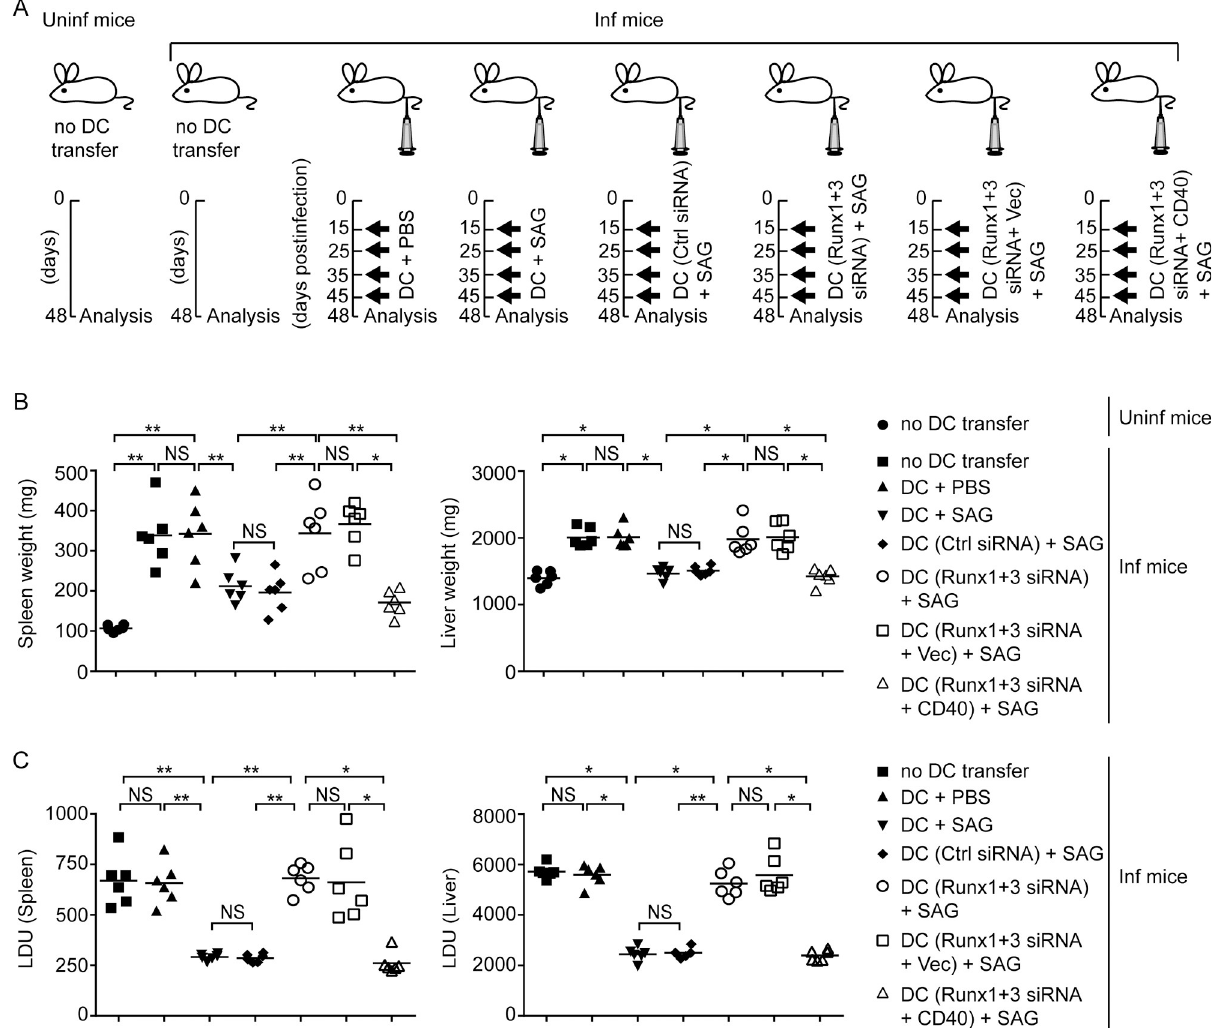
Fig 9. Runx-mediated CD40 expression is required for clearance of LD infection in mice by SAG-treated DCs. (A) Experimental scheme for adoptive transfer experiments. BALB/c BMDCs were treated with PBS or SAG for 24 h. Alternatively, BALB/c BMDCs were transfected with control siRNA, or with Runx1 and Runx3 siRNAs alone or together with an empty vector (Vec) or CD40-expressing vector (CD40) prior to SAG treatment (see S17 Fig showing the level of CD40 expression on these DCs). After such treatment, DCs were transferred i.v. into LD-infected (Inf) BALB/c mice on days 15, 25, 35 and 45 postinfection. In some sets of the experiment, age-matched uninfected (Uninf) mice and LD-infected BALB/c mice were left without any DC transfer (no DC transfer). On day 48 postinfection, spleens and livers were isolated for analysis. (B and C) Spleen and liver weights (B), and splenic and liver parasite burden [measured by stamp-smear method and presented as Leishman-Donovan Unit (LDU); (C)] in mice treated as in (A); assessed on day 48 postinfection. Each symbol represents an individual mouse. Data are compilation of two separate experiments ( n = 3 mice per group in each experiment). The horizontal bars represent the mean. The representative pictures of spleens and livers from these mice are shown in S18 Fig. In all experiments, LD strain AG83 was used. � p < 0.001, �� p < 0.01; NS, not